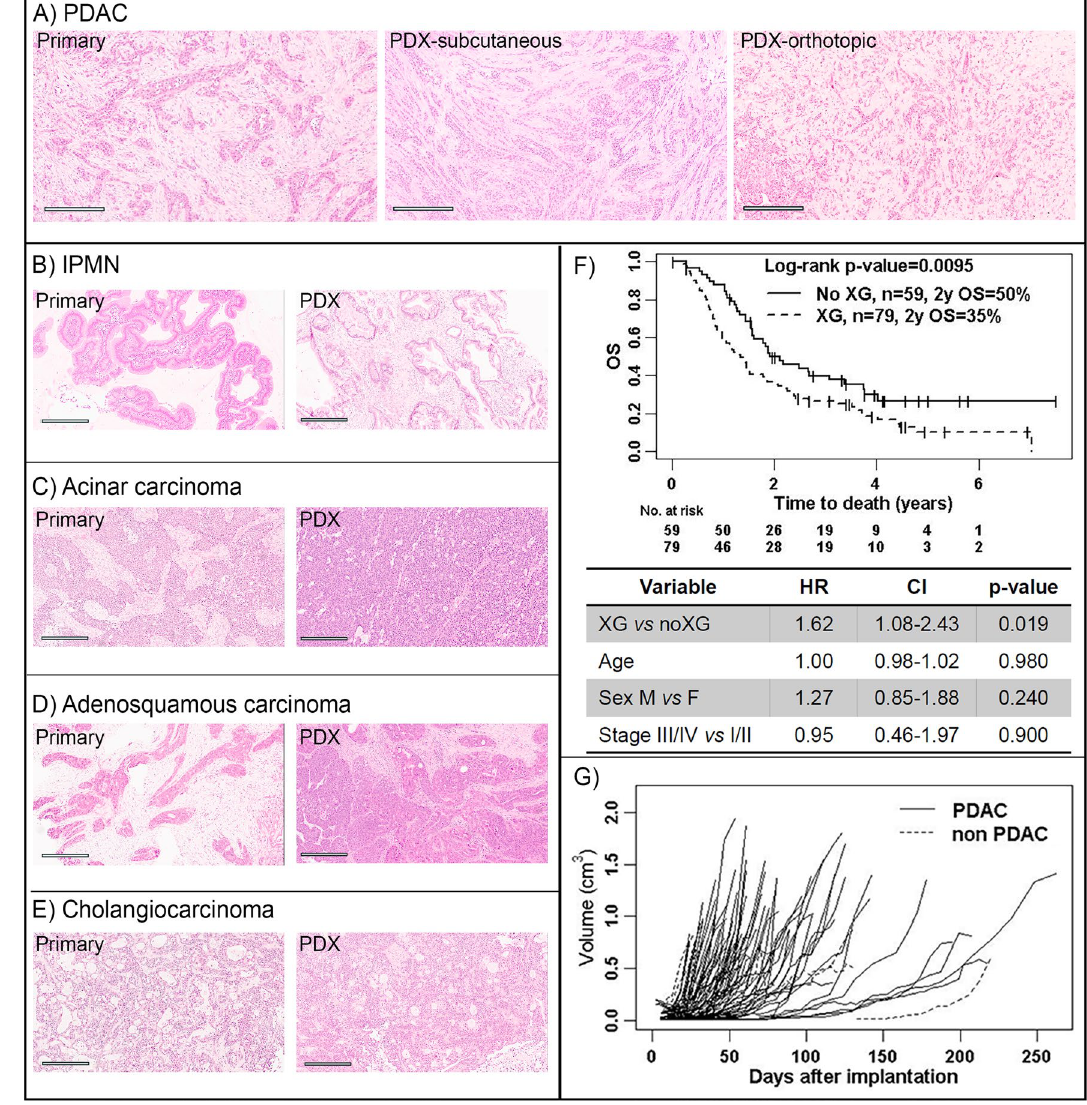
Figure 1. Establishment of PDX models from resected tumors. Pairs of patient primary-PDX tumors show a high overlap of histological features. ( A ) A poorly differentiated PDAC (OCIP88) with cords of infiltrating tumor cells. ( B ) An IPMN (OCIP250) with papillary growth lined by columnar and mucinous tumor cells. ( C ) An acinar cell carcinoma (OCIP270) showing tumor cells with eosinophilic cytoplasm growing in sheets. ( D ) An adenosquamous carcinoma (OCIP130) showing highly similar histological appearances in both the primary and PDX tumors. ( E ) A cholangiocarcinoma (OCIP194) with focal glandular structures. Scale bars are 300 μm. Histology images were color balanced to compensate for over-/under-staining, no features were altered in the process. ( F ) A significantly lower rate of overall survival (OS) was associated with patients’ tumors that had successful initial engraftment (XG at P0) compared to those that failed engraftment (No XG). A multivariate table shows analysis of variables with hazard ratio (HR). ( G ) Growths of individual pancreatic tumors to an average of 1.5 cm 3 at humane endpoint, at the flank of NOD